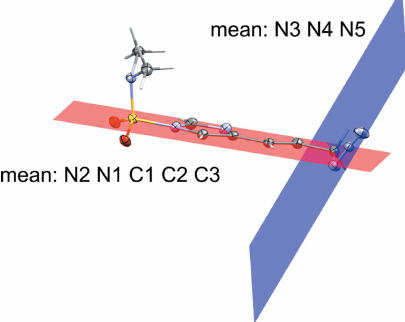
Figure 3 Dihedral planes between imidazole and allylic azide for compound